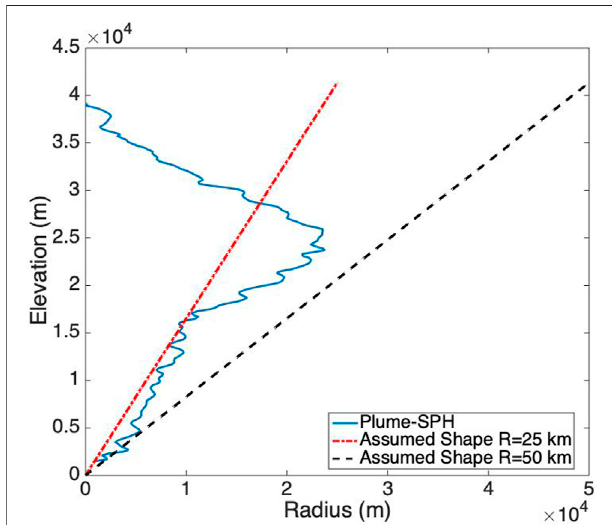
FIGURE10| Comparisonbetweenradiusofinitialashcloudscreatedby 3D plume model (Plume-SPH) and assumed initialash cloud shape ( Eq.15 ) in Puff. The plume shape expression used in Puff de fi nes an inverted cone whose actual shape changes when “ horizontal spread ” takes different values. R (cid:2) 25 km is corresponding to “ horizontal spread ” equals to 50 km. R (cid:2) 50 km is corresponding to “ horizontal spread ” equals to 100 km.